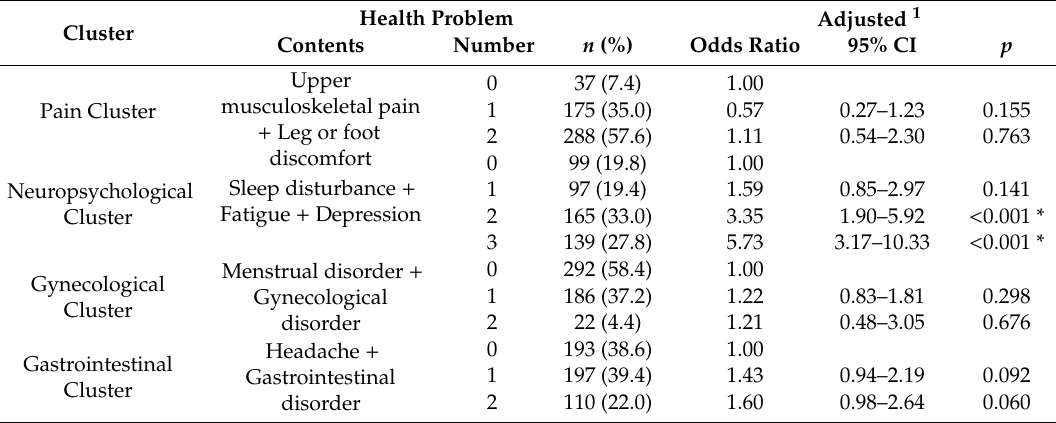
Figure 2. Dendrogram of the health problem clusters. Table 3. Association between clusters of health problems and turnover intention using multiple ordinal logistic